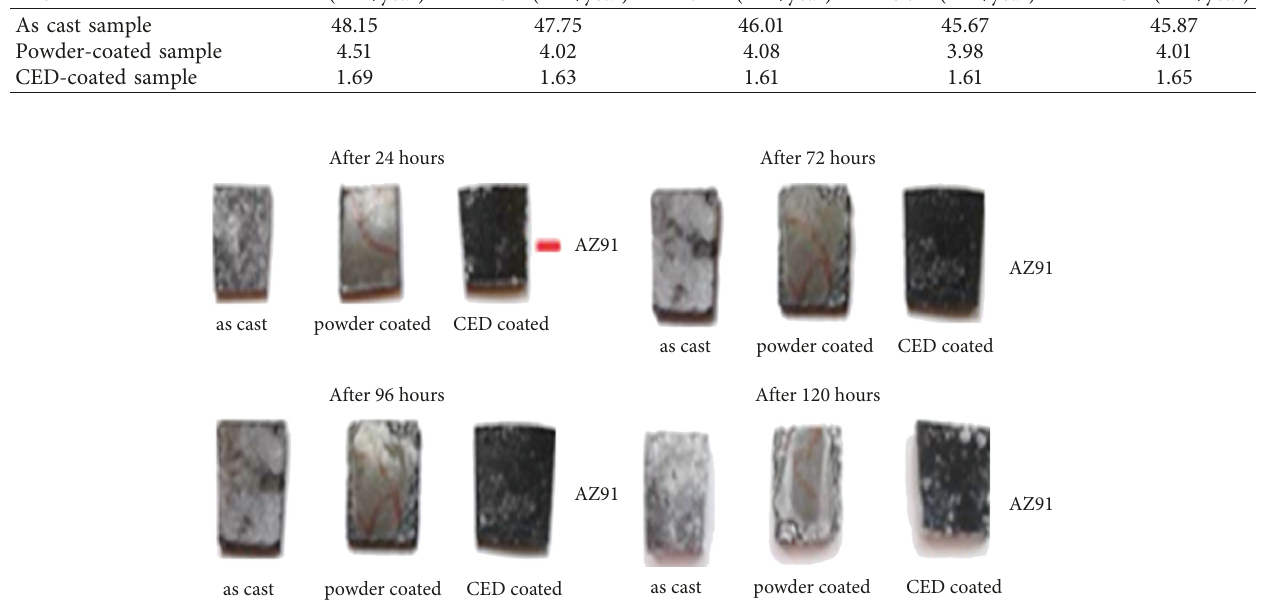
Figure 13: Samples after immersion test of 24h, 72 h, 96h, and 120h.